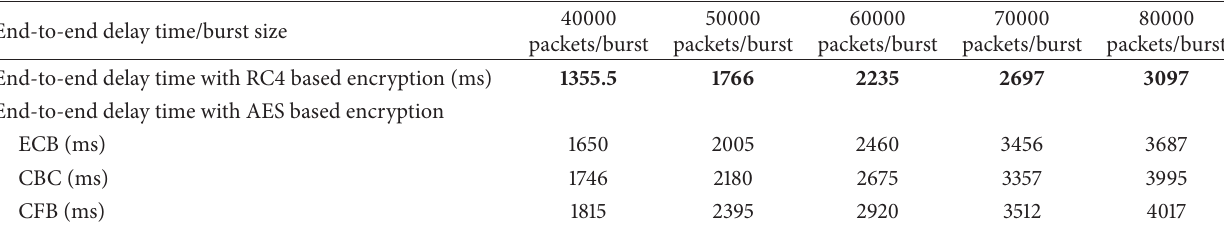
Table 8: End-to-end delay calculation using RC4 and AES.